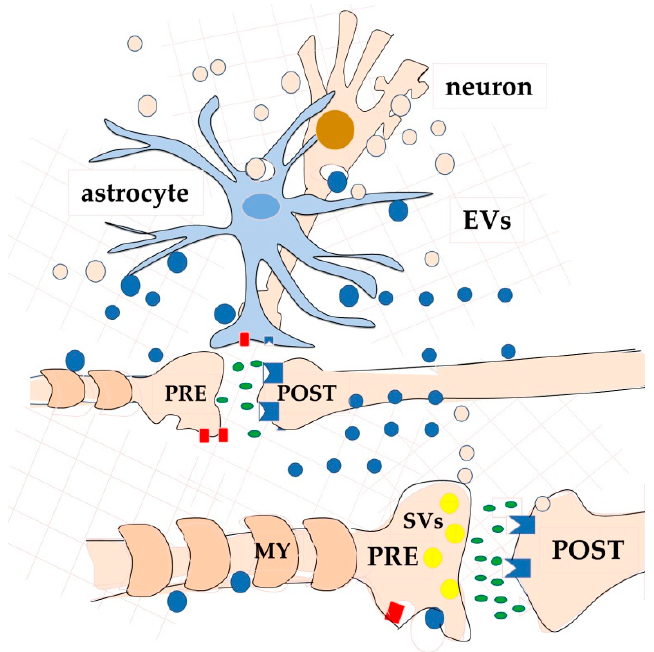
Figure 3. Schematic drawings of one further aspect of VT-neurotransmission [114]. A variety of molecules and metabolites can be exchanged both among neurons, and among neurons and other brain cells, via extracellular vesicles (EVs) of different size and composition. Neurons release EVs (probably for most exosomes) mainly from the soma and dendrites. As an example of a glial cell, an astrocyte is drawn. For clarity, vesicles have been depicted the same colour as the producing cell: light pink produced by the neuron and blue produced by the astrocyte.